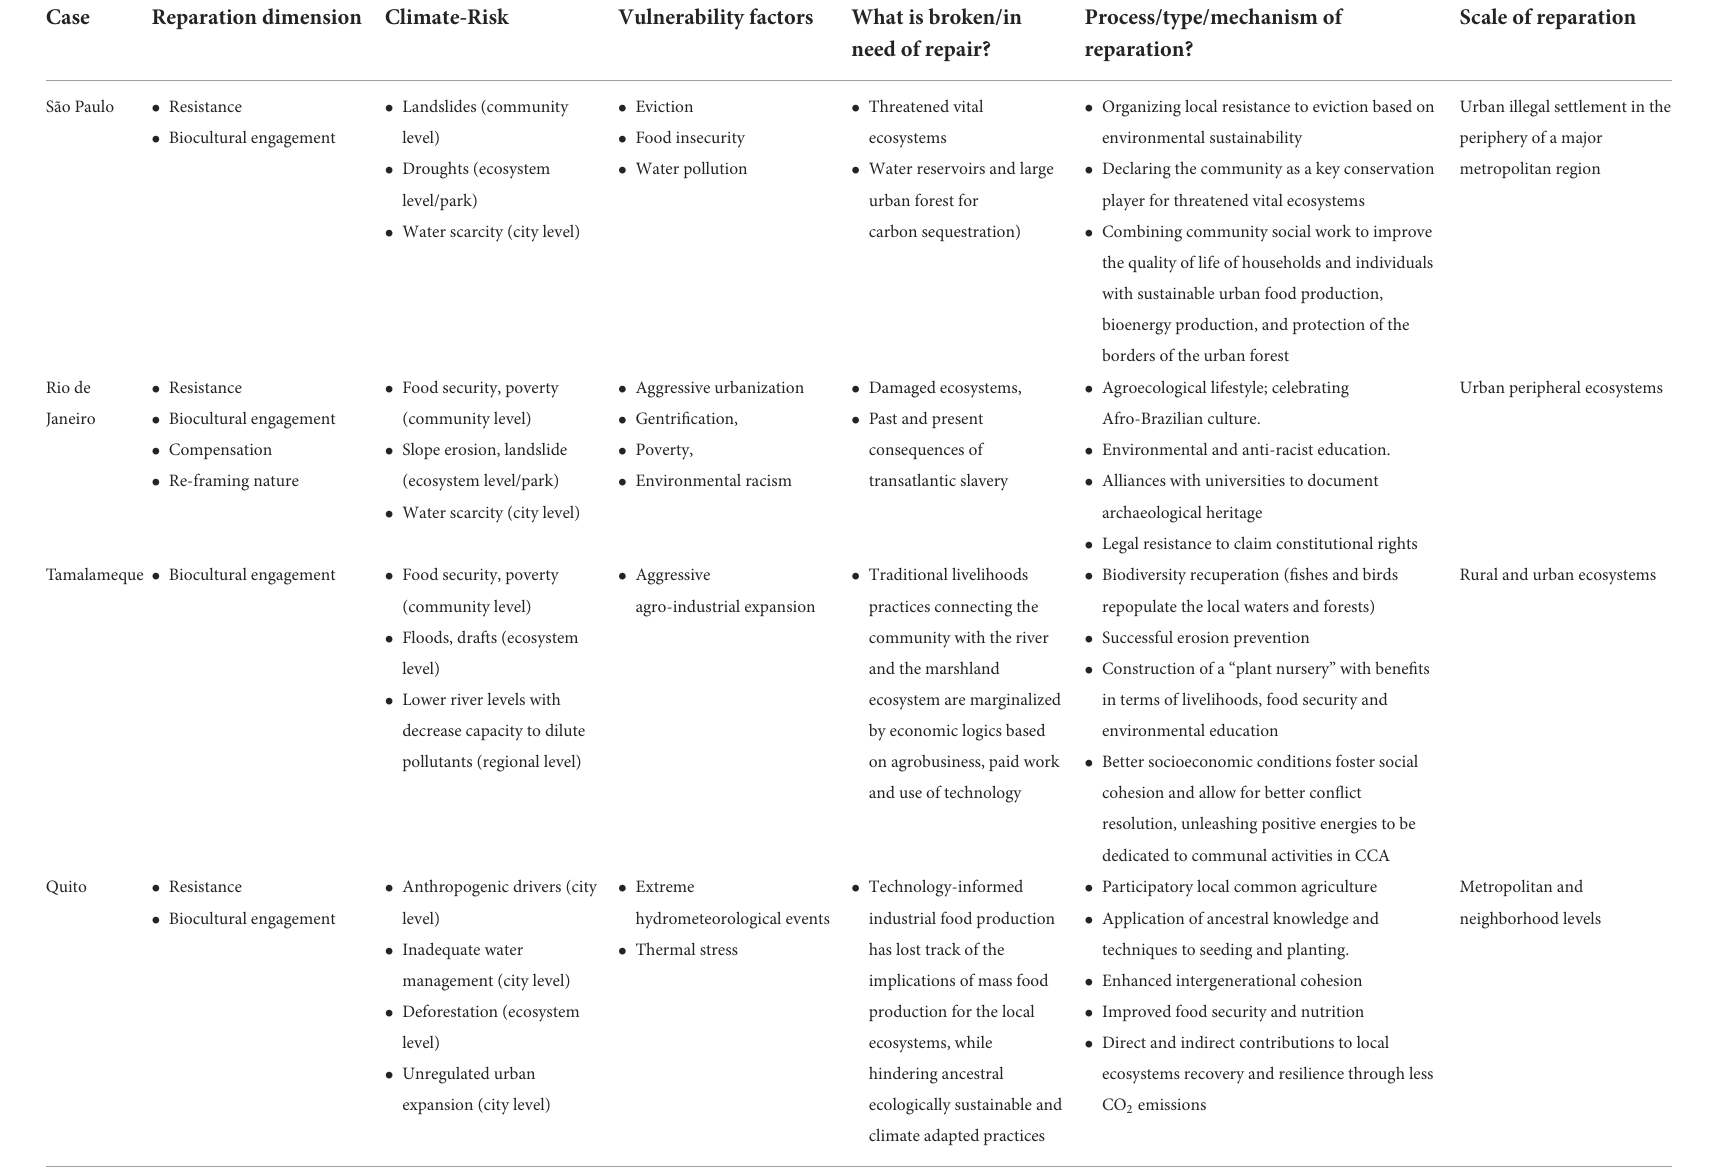
TABLE 2 Overview of the case studies according to key dimensions of reparation